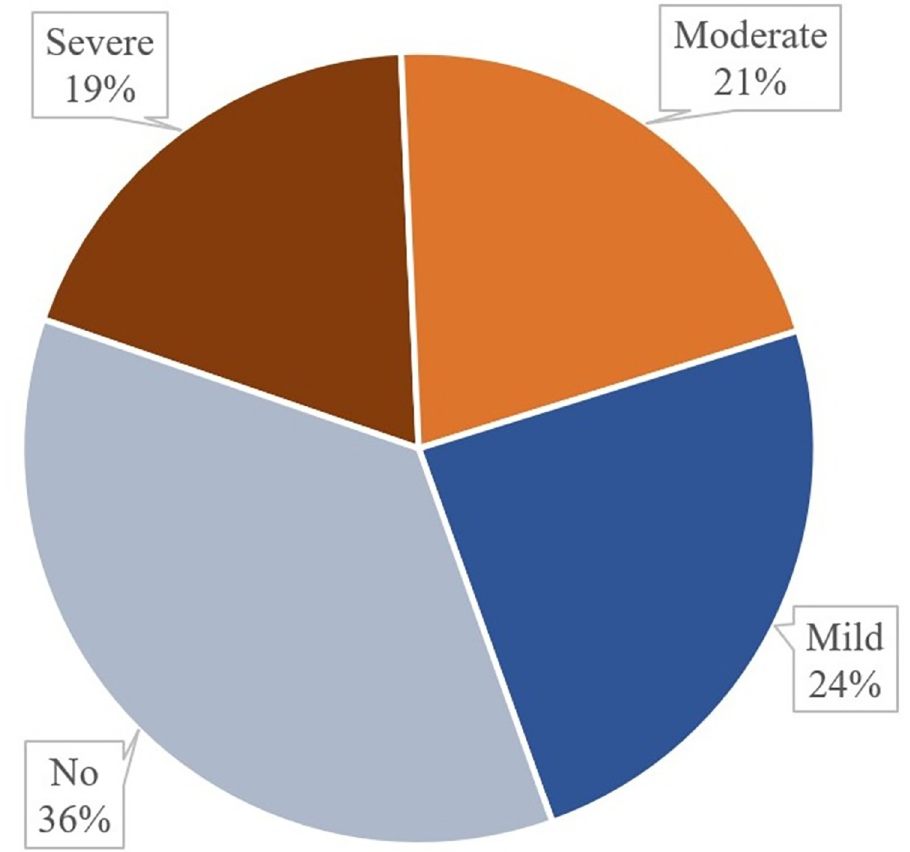
Fig 1. Prevalence of musculoskeletal pain among the